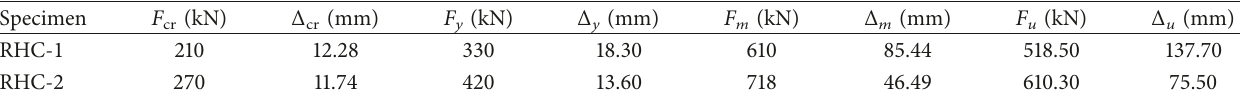
Figure 14: Hysteresis curves and skeleton curves of RHC-1 and RHC-2. (a) Hysteresis curve of RHC-1. (b) Skeleton curve of RHC-1. (c) Hysteresis curve of RHC-2. (d) Skeleton curve of RHC-2. Table 4: Test results of two